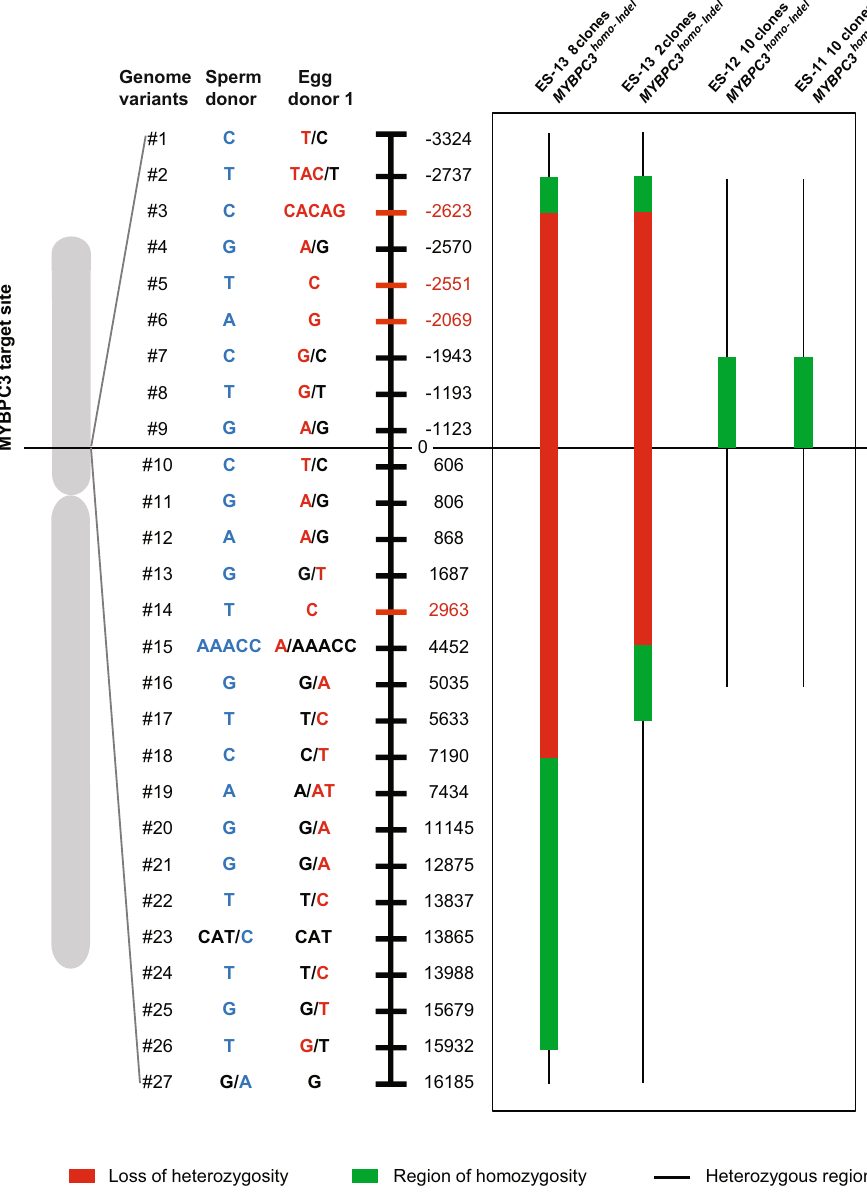
Fig. 5 | LOH due to interallelic gene conversion in MYBPC3 homo-Indel ESC clones. LOH induced by long gene conversion tracts. Schematic map of 27 informative genome variants or SNPs located upstream and downstream at various distances from the homozygous MYBPC3 locus differentiating parental alleles in MYBP3 homo- Indel and MYBPC3 homo-WT ESC clones derived from edited embryos. LOH at each SNP site and genome variant was determined and compared to ESC clones with